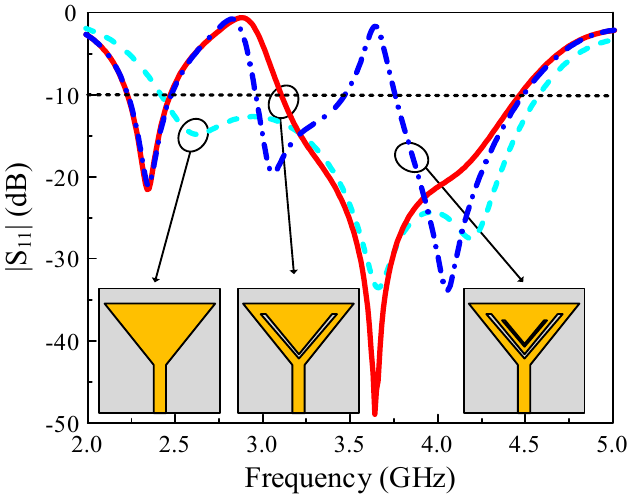
Figure 3. S 11 for wideband antenna and wideband antenna with single and dual-notch bands.